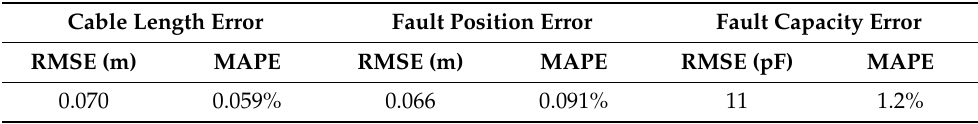
Table 3. Estimation errors obtained for the validation